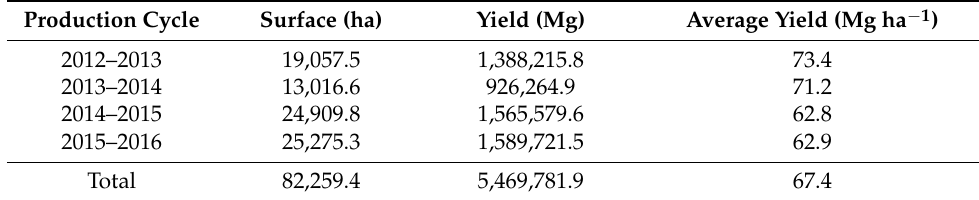
Table 3. Surface cropping, total, and average cane yield per cycle. Production